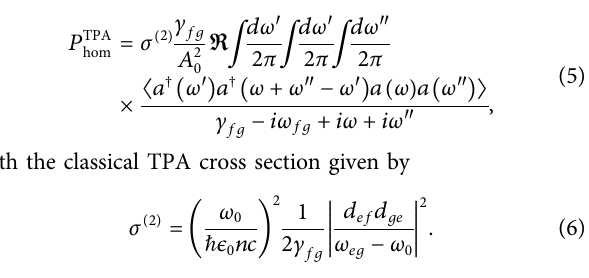
Frontiers in Physics |